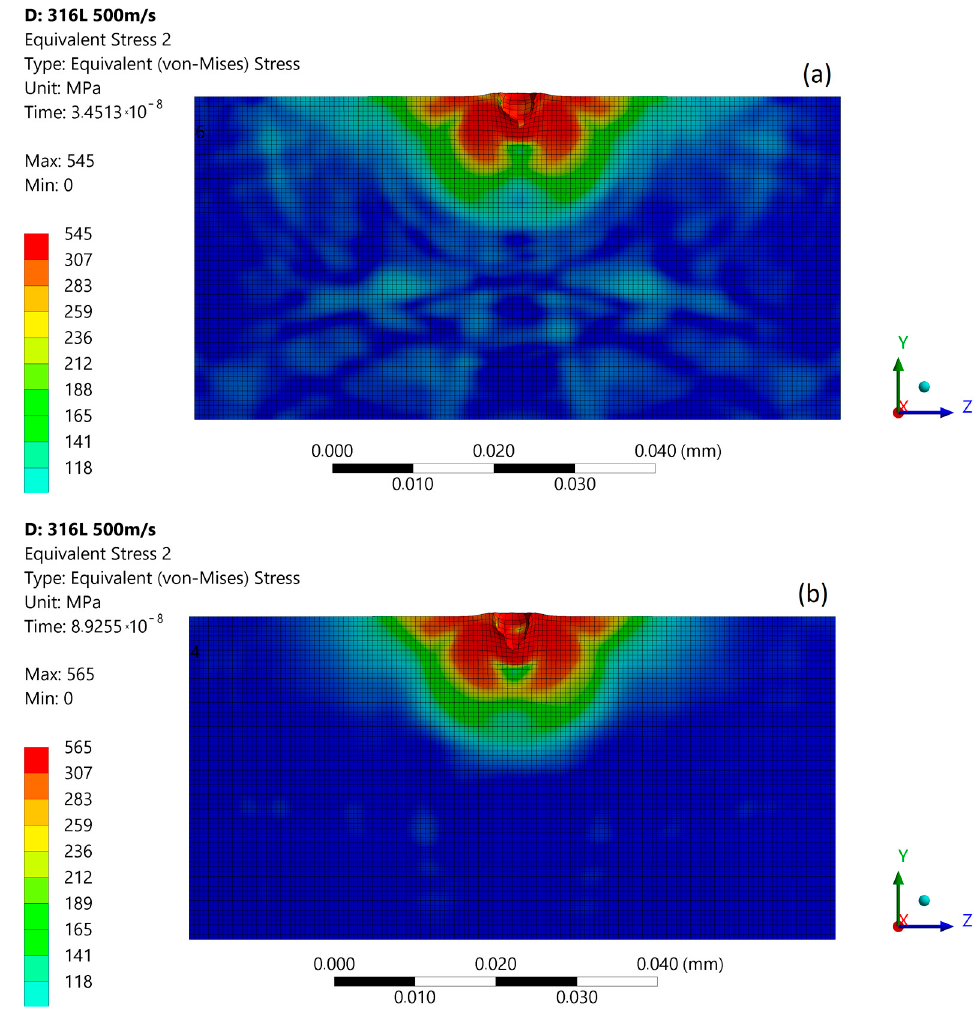
Figure 14. Exceeded yield stress zone (over 307 MPa—red) of 316L stainless steel: ( a ) after first micro ‐ jet impact; ( b ) after subsequent micro ‐ jet impact; at 500 m/s.